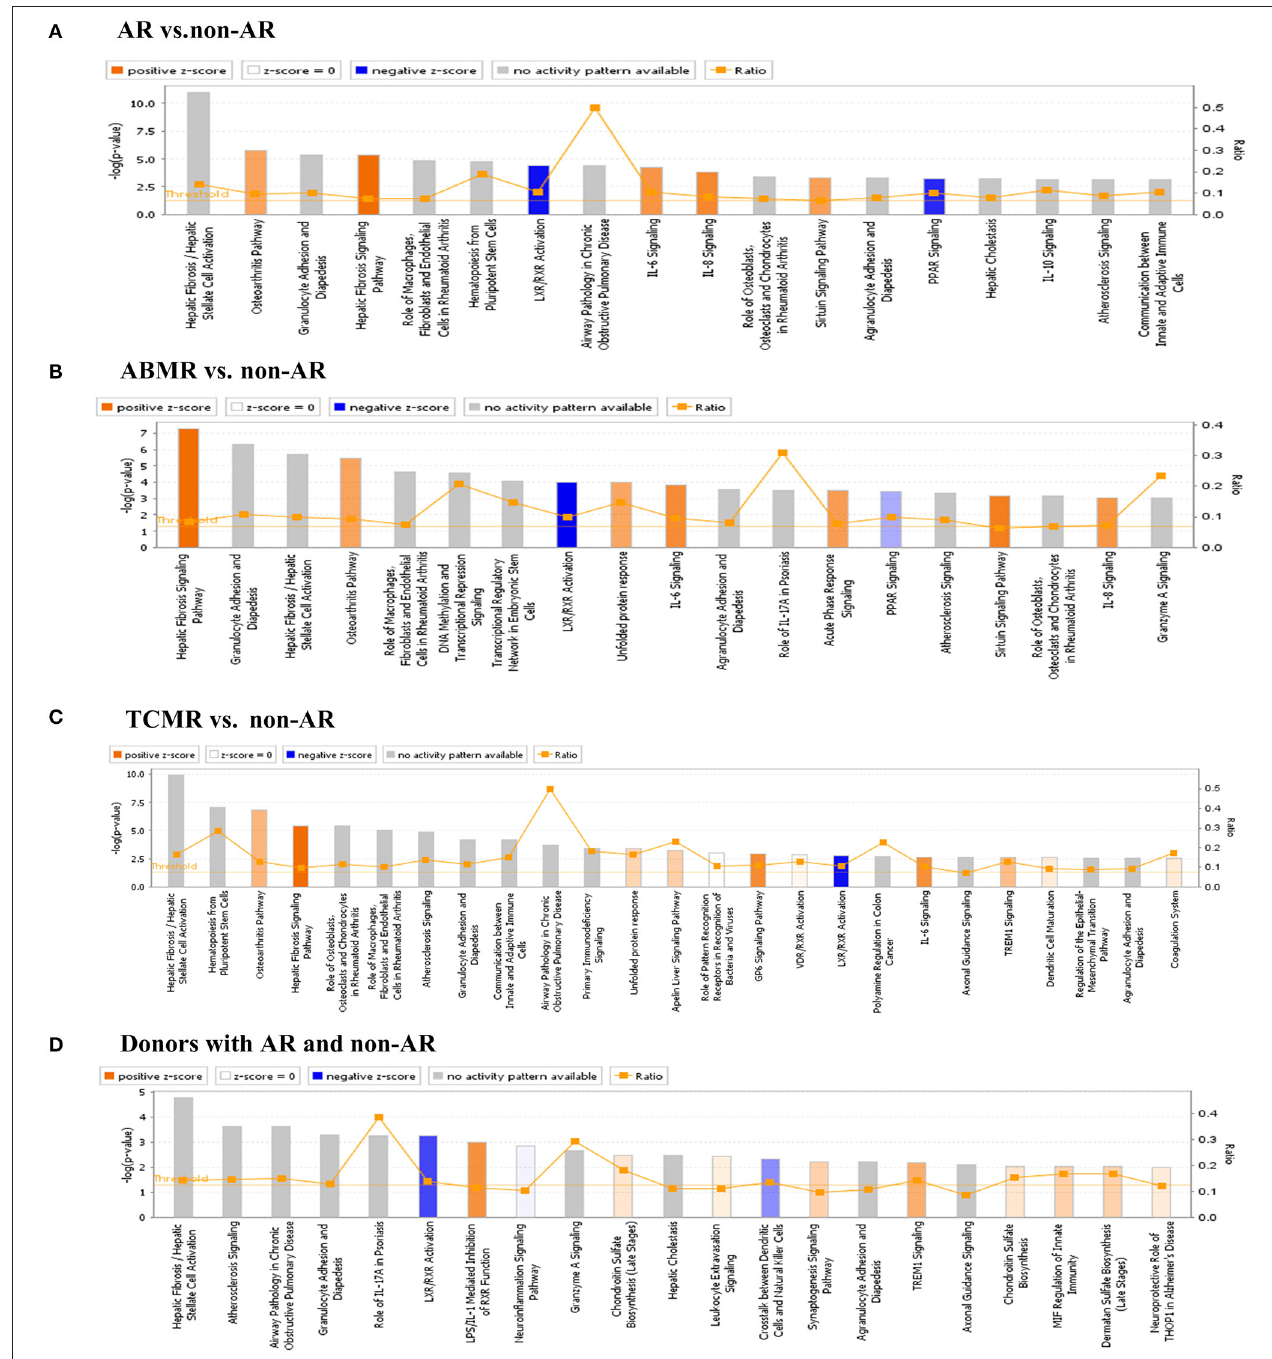
FIGURE 6 | IPA analysis of DEGs. (A) IPA analysis of DEGs in AR vs. non-AR group. IL-6 and IL-8 signalling, etc. had a positive Z-score, whereas LXR/RXR activation and PPAR signalling had a negative Z-score. (B) IPA analysis of DEGs in ABMR vs. non-AR group. Hepatic fibrosis pathway, IL-6 and IL-8 signalling, etc., had a positive Z-score, whereas LXR/RXR activation and PPAR signalling had a negative Z-score. (C) IPA analysis of DEGs in TCMR vs. non-AR group. Hepatic fibrosis signalling pathway and IL-6 signalling, etc. had a positive Z-score, whereas LXR/RXR activation signalling had a negative Z-score. (D) IPA analysis of DEGs in donors with AR vs. non-AR group. LPS/IL-1-mediated inhibition of RXR function and TREM1 signalling etc. had a positive Z-score and LXR/RXR activation signalling had a negative Z-score.